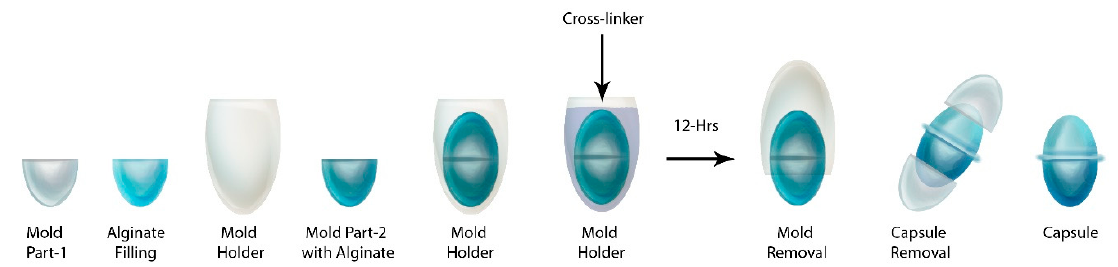
Figure 11. Schematic representing the process of alginate capsule production. The process included filling the mold with alginate with or without MMT, placing the 2-parts mold into the mold holder, and addition of cross-linker followed by removal of mold after 12 h.